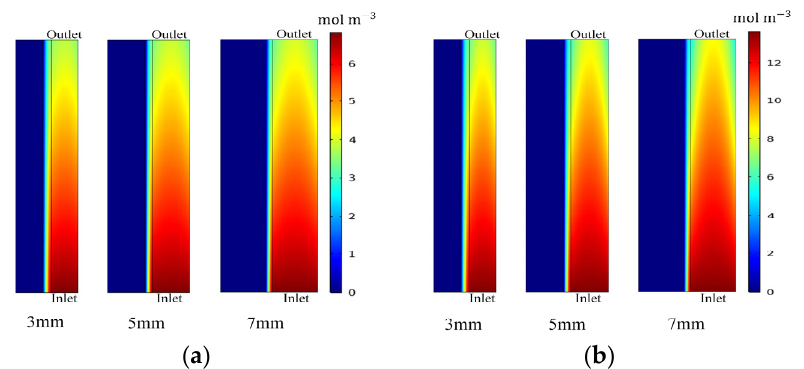
Figure 9. Bromine concentration distribution in the positive electrode at t = 0.85 h for battery with different electrode thicknesses at current densities of ( a ) 20 mA cm − 2 and ( b ) 40 mA cm − 2 .